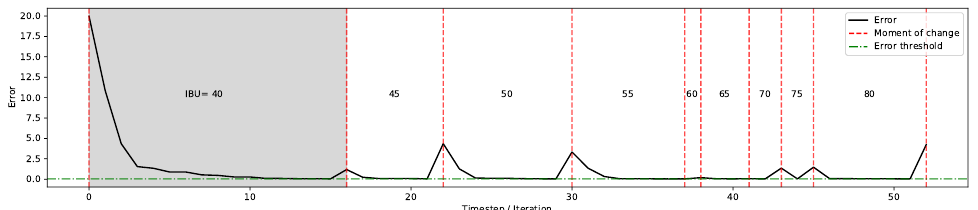
Figure 9. Applying gradual changes to preferences: gradually increasing IBU for Guinness Extra Stout by 5. The figure shows the gradual change (from IBU = 40 onwards) requires less than half the time steps to accommodate user’s updated